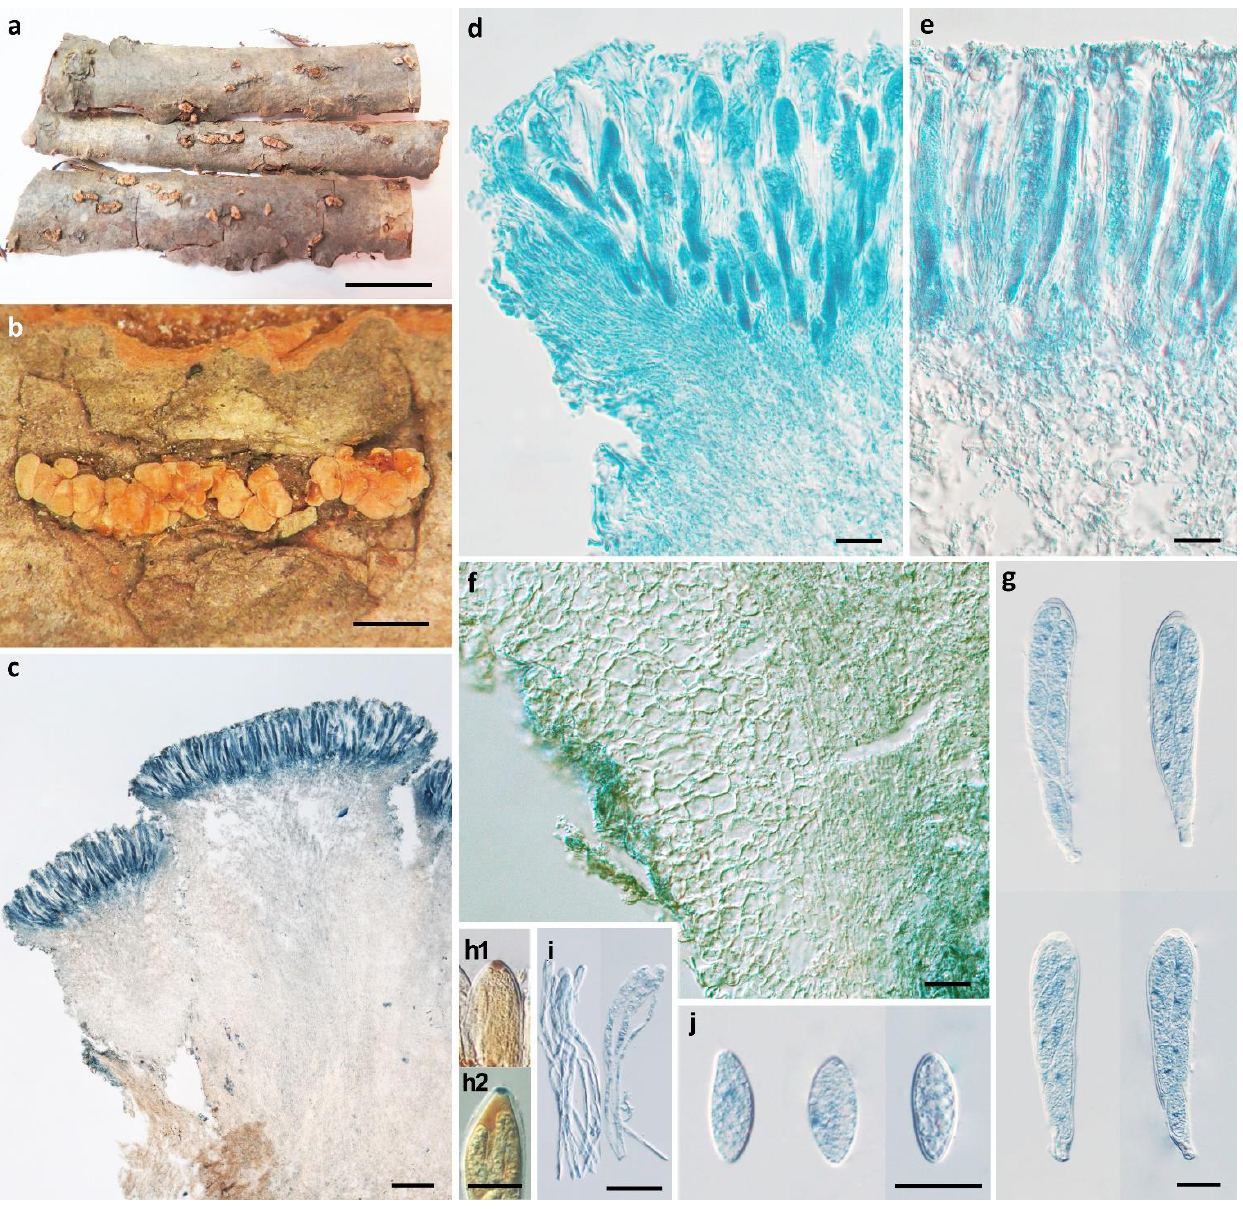
Figure 4. Pezicula acericola (Peck) Peck ex Sacc. & Berl. (HMAS 33726). ( a , b ) Dry apothecia on natural substrate; ( c ) longitudinal section of apothecia; ( d ) longitudinal section of apothecium (half) showing hymenium and excipular structure; ( e ) hymenium; ( f ) excipular structure at flank; ( g ) asci; ( h1 ) IKI reaction of ascus apical ring without KOH pretreatment; ( h2 ) IKI reaction of ascus apical ring after KOH pretreatment; ( i ) paraphyses; ( j ) ascospores. Scale bars: ( a ) = 2 cm; ( b ) = 2 mm; ( c ) = 100 µ m; ( d – j ) = 20 µ m. Mounting media: ( c – g , i , j ) lactophenol cotton blue; ( h1 , h2 ) Lugol’s solution. Apothecia erumpent, a few to a large number in circular to linear clusters on a basal stroma, discoid with surface plane to slightly convex, margin entire or irregularly torn, short stipitate; hymenium yellow when fresh, light cinnamon when dry, 0.3 – 3 mm in diam; receptacle concolorous to paler than hymenium. Ectal excipulum of textura angularis, 25 – 180 μ m thick, cells subhyaline to light brown, isodiametric or nearly so, 4 – 16.5 μ m in diam. Medullary excipulum of textura intricata, 20 – 190 μ m thick, hyphae hyaline to light brown, 4 – 8.5 μ m wide. Subhymenium indistinguishable. Hymenium 125 – 150 μ m thick. Asci arising from croziers, clavate, apex conical-rounded, narrowed gradually or abruptly into a short stalk, 8-spored, apical rings J+, becoming blue only after KOH pre- treatment in Melzer’s reagent, and becoming red without KOH pretreatment and blue